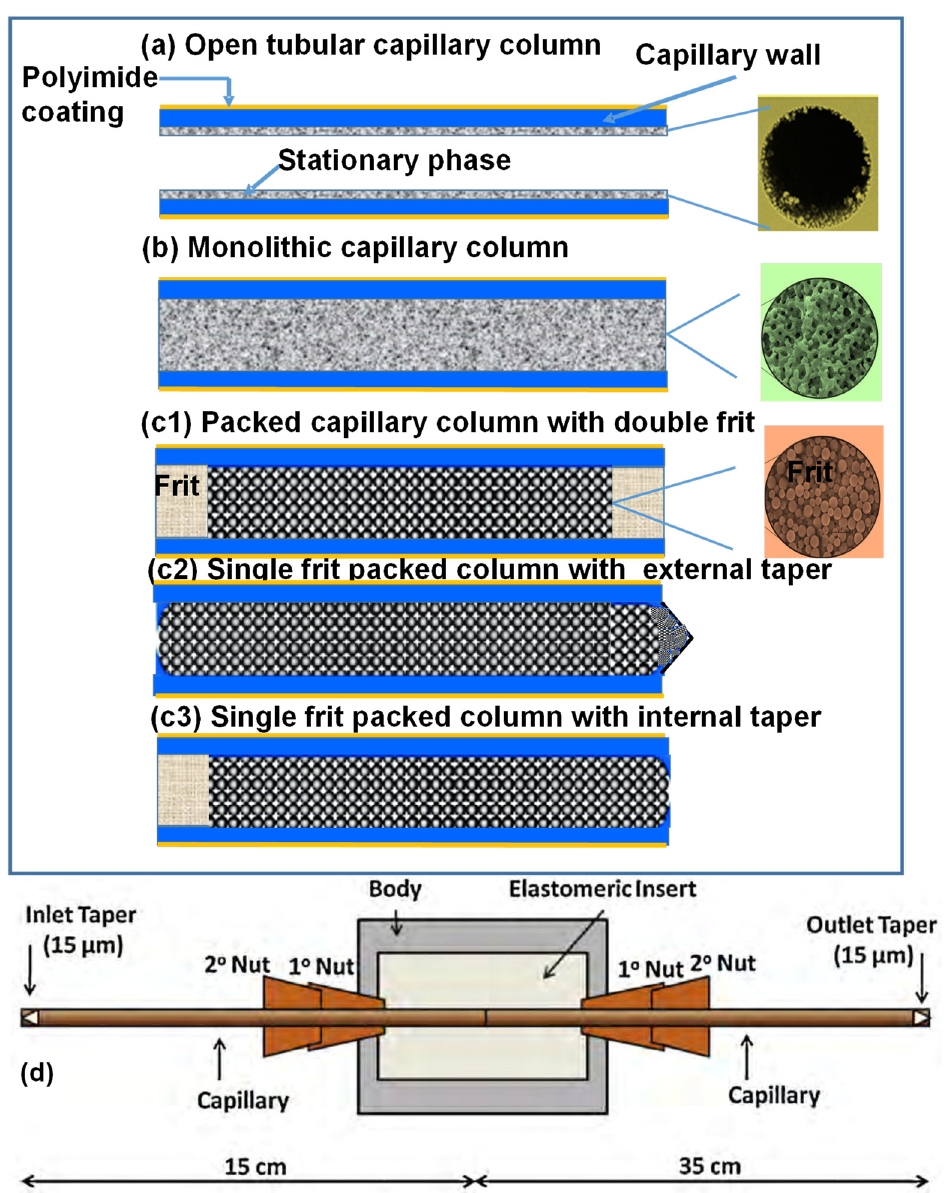
Figure 3. A schematic representation for the types of columns used in chiral CE-MS: ( a ) open tubular column, ( b ) monolithic column, and packed column with ( c1 ) double frit; ( c2 ) single frit and external taper, and ( c3 ) single frit and internal taper; ( d ) fritless column with the new objective picoclear connector. The elastomeric insert of the connector ensures that the two capillaries do not grind together when joined. The arrows at the bottom represent the lengths of the inlet packed portion (15 cm) and outlet packed portion (35 cm) of the fritless column (not to scale). ( a – c3 ) is reproduced with permission from A. S. M. Mojibur Rahman Chawdhury (dissertation in preparation) at Georgia State University, and ( d ) and Figure caption are adapted from Bragg et al. [15] with permission from Elsevier.